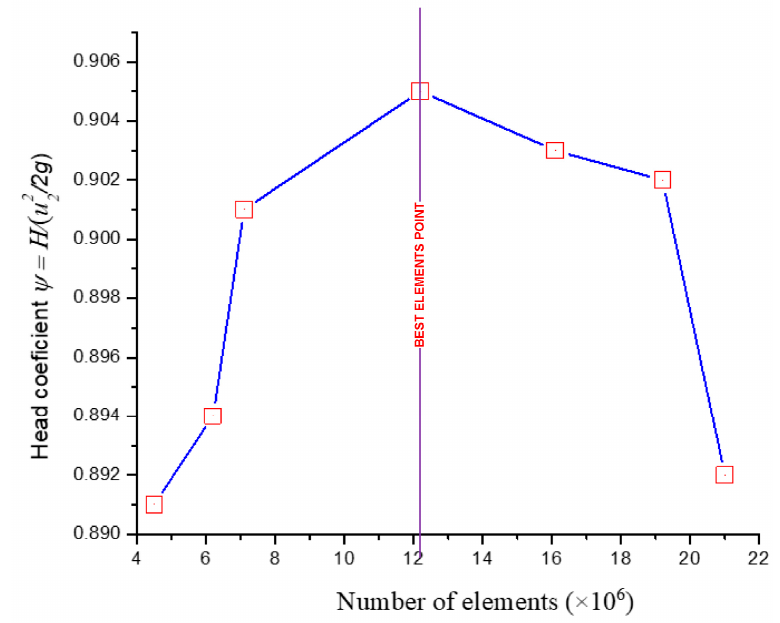
Figure 10. Testing independent mesh in this